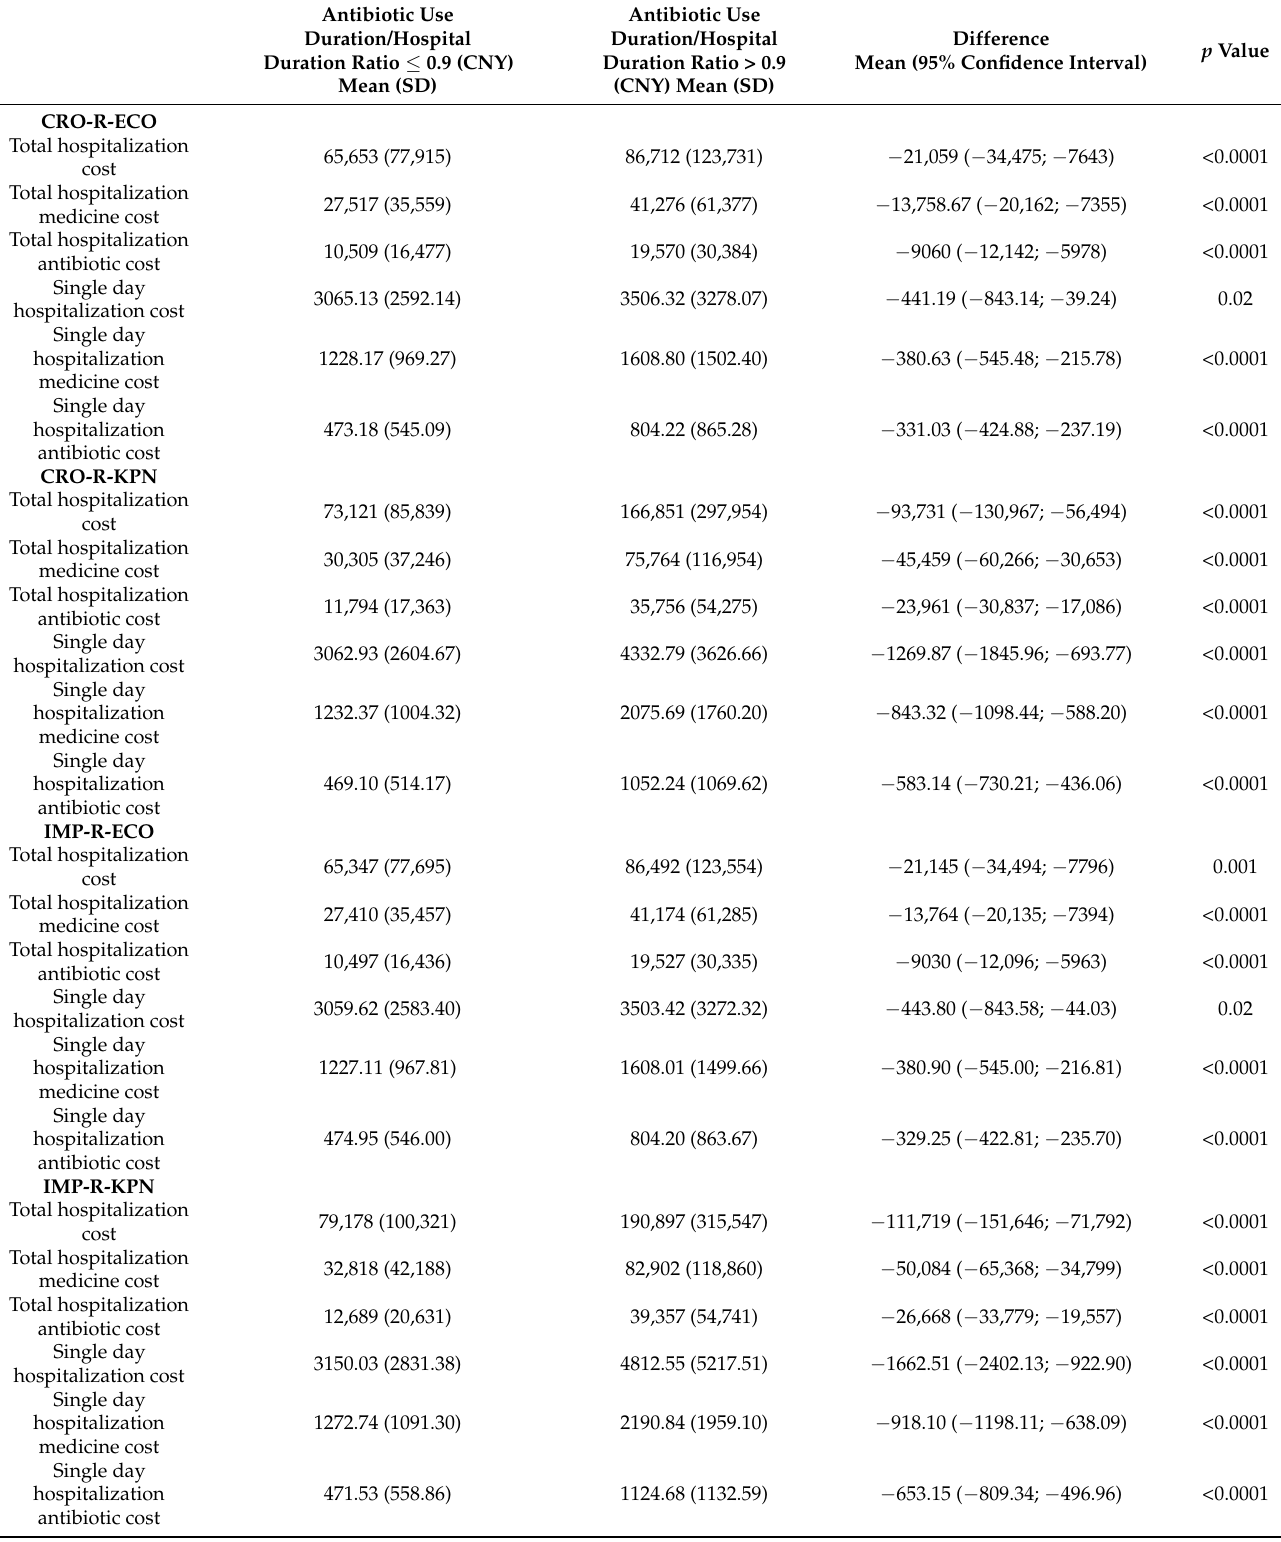
Table 7. Cost comparisons ( t -tests) for antibiotic use duration/hospitalization duration ratio ≤ 0.9 and >0.9 in bloodstream infection with multiple antibiotic-resistant bacteria and their corresponding antibiotic-sensitive